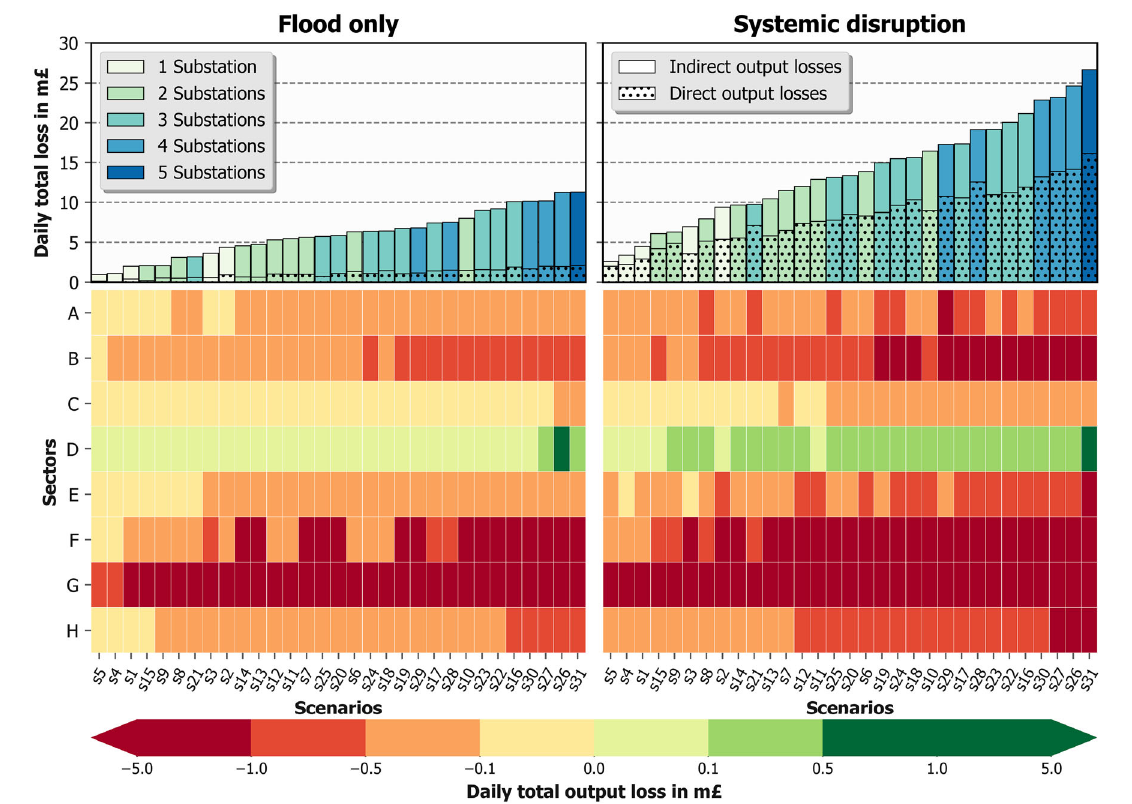
Fig. 7 Total daily output losses for the United Kingdom for 31 failure combinations. The left panel shows the impacts due to a flood with a return period of 1/1000. The right panel shows the impacts due